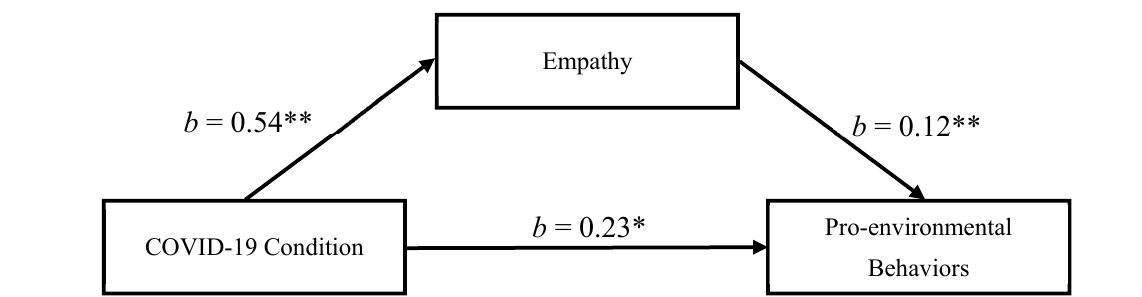
Figure 3. Empathy as mediator of the relationship between condition and pro-environmental behaviors in Study 2. Note. Reported are standardized regression coefficients and standardized indirect effect with bootstrapped 95% confidence interval, ** p < 0.01, * p < 0.05.